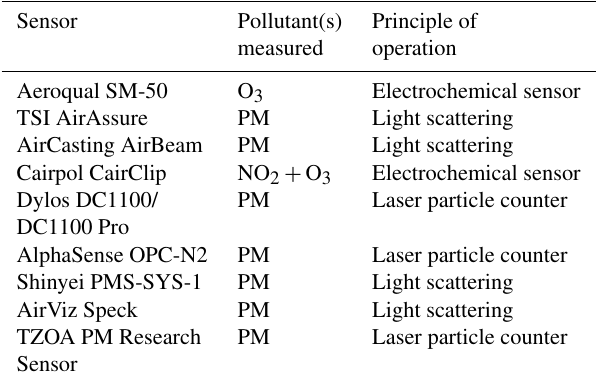
Table 1. Sensors used during the CAIRSENSE – Denver study.